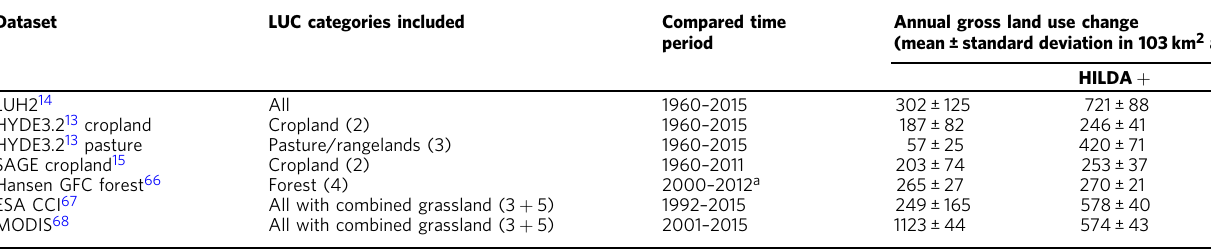
Table 1 Comparison of land use/cover